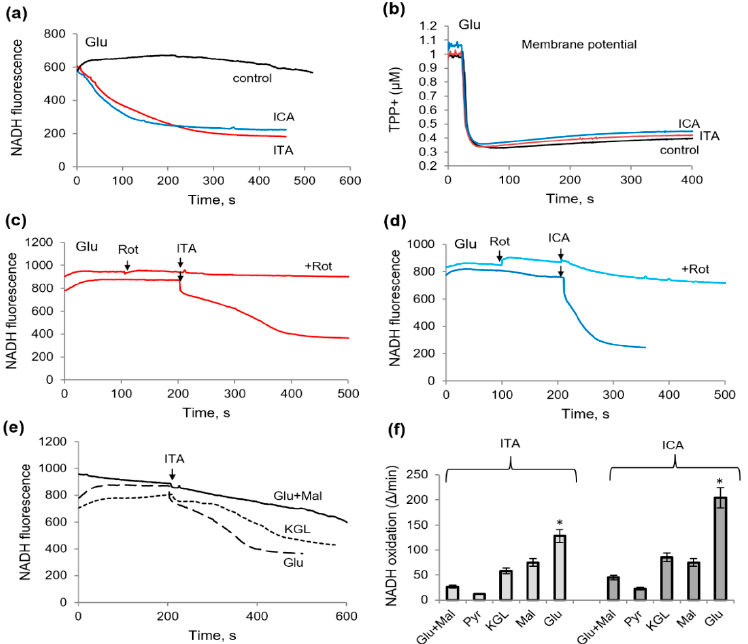
Figure 3. Influence of itaconic and indolcarboxylic acids on the oxidation of glutamate and other NAD-dependent substrates, as measured by NADH fluorescence assay. The activation of NADH oxidation by ICA (250 µ M) and ITA (2 mM) in the presence of 2 mM glutamate ( a ); ITA and ICA do not influence the membrane potential supported by glutamate ( b ); the elimination of NADH oxidation induced by ITA ( c ) and ICA ( d ) by rotenone; the influence of ITA on NADH oxidation in the presence of glutamate plus malate, 2-oxoglutarate, and glutamate ( e ); influence of ITA (2 mM) and ICA (250 µ M) on NADH oxidation rate in the presence of different NAD-dependent substrates ( f ). Asterisks (*) indicate values that differ significantly from the control values ( p <